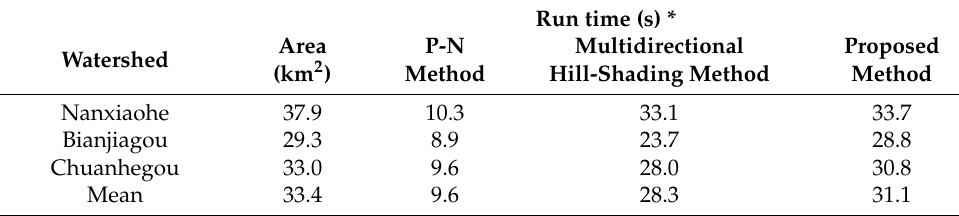
Table 5. Efficiency assessment of the three